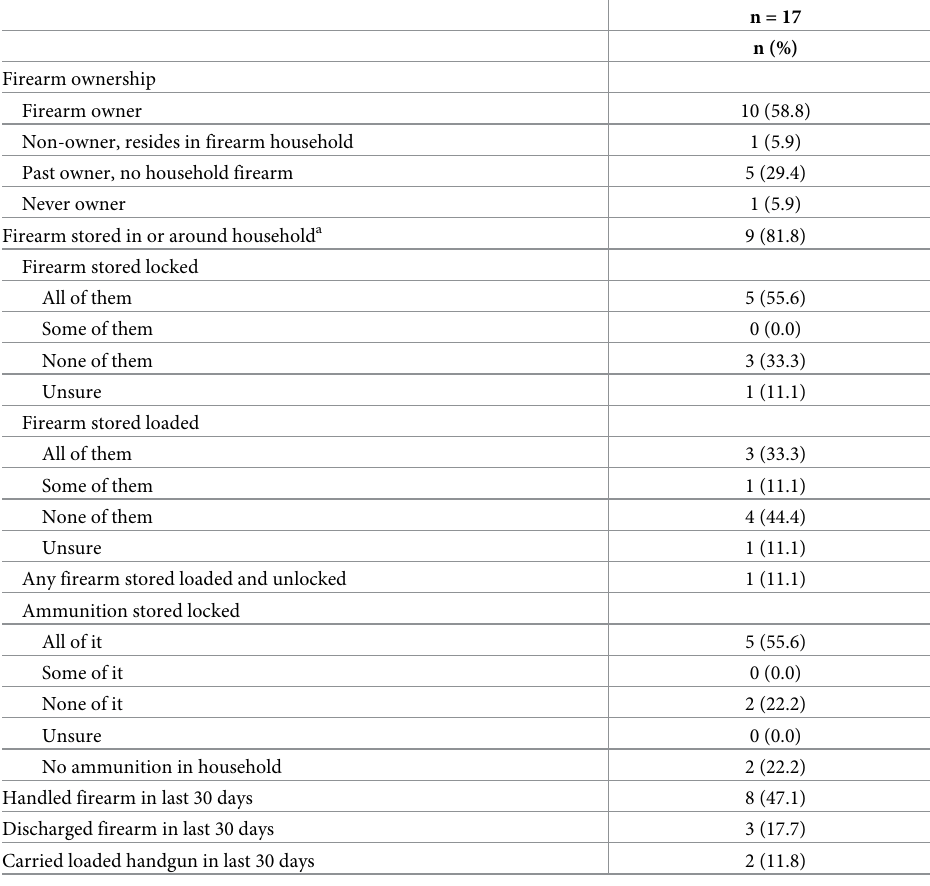
Table 3. Firearm